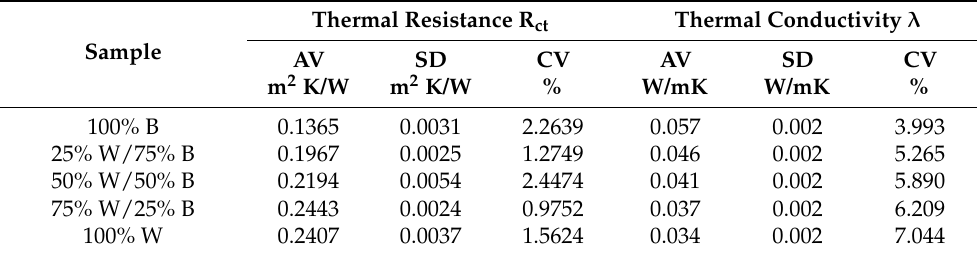
Table 2. Thermal resistance, R ct , and thermal conductivity, λ ,